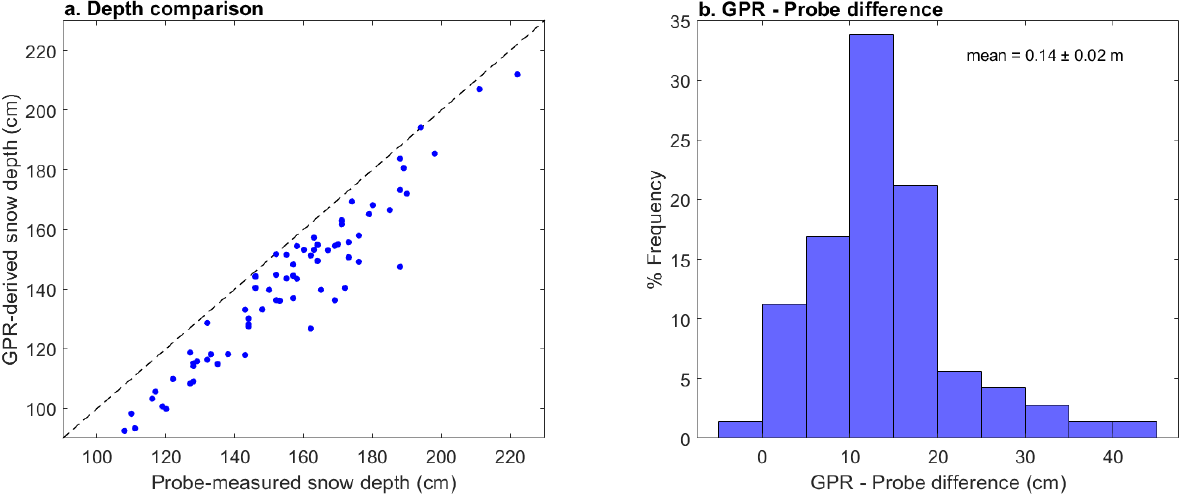
Figure 5. ( a ) Probe-measured snow depth compared to GPR-derived snow depths ( n = 73). GPR-derived snow depths were calculated using bulk snow density measured in the snowpit and Equation (3). ( b ) Histogram for the difference between probe-derived snow depths and GPR-derived snow depths. Confidence interval calculated using the t-distribution.